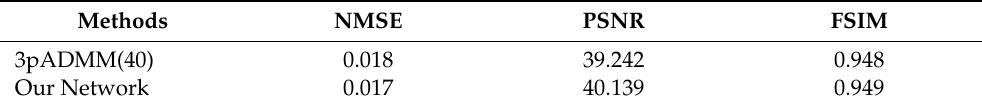
Table 4. Low-dose reconstruction results for different